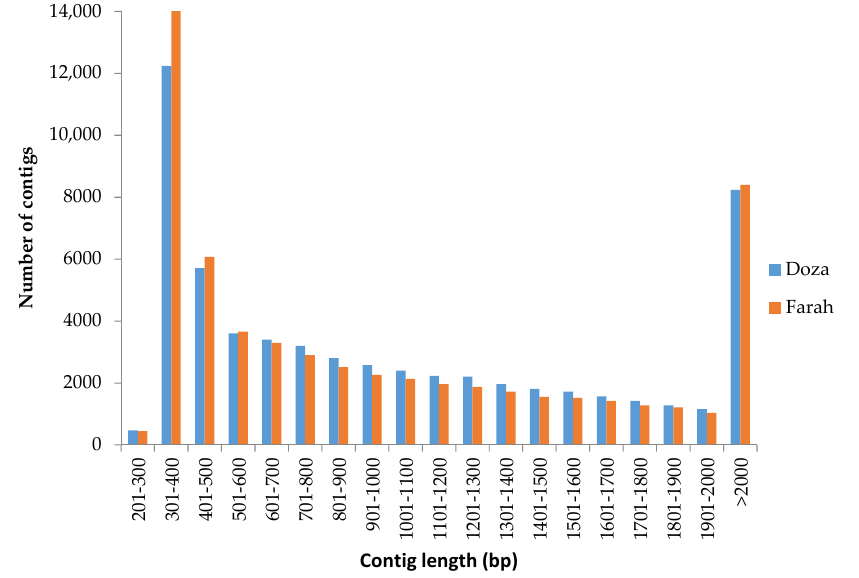
Figure 1. Distribution of the assembled transcript length from the Doza ‐ specific and Farah ‐ specific assemblies.